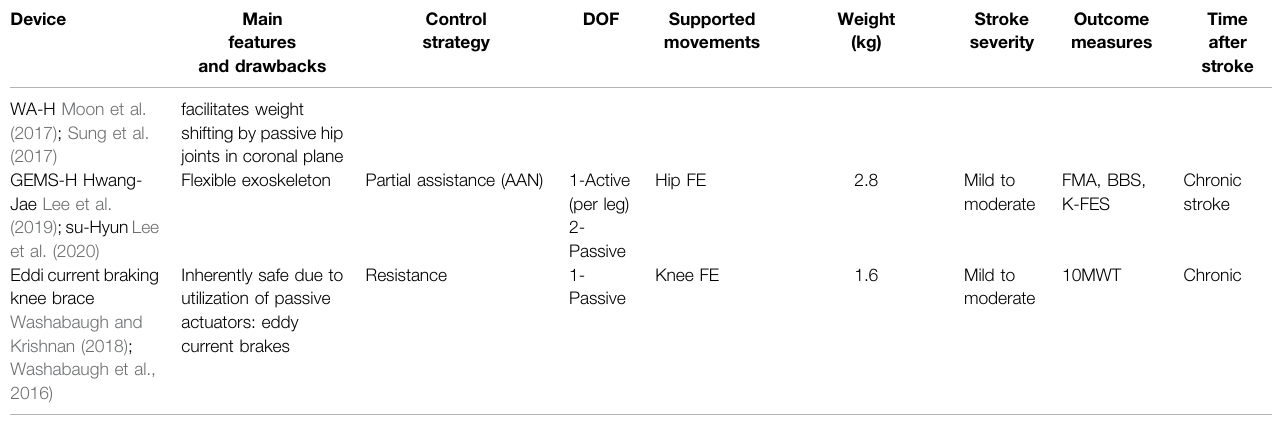
TABLE 3 | ( Continued ) Summary of state-of-the-art robotic systems for home-based lower-limb rehabilitation. Device